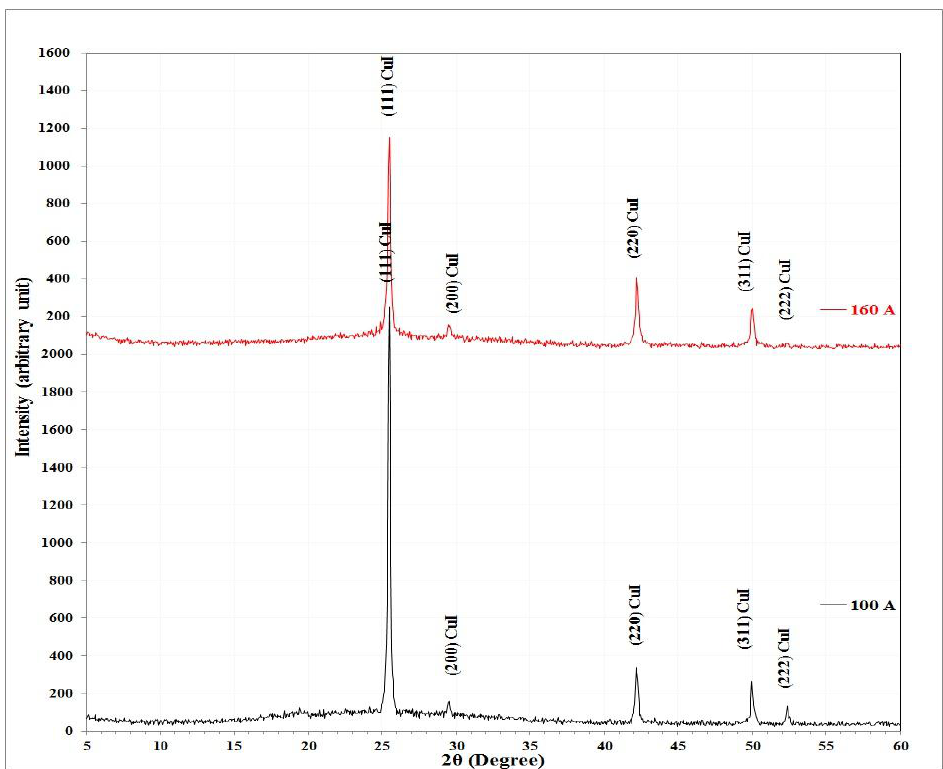
Fig. 2: X-ray diffraction patterns for produced CuI nanoparticles using different current.